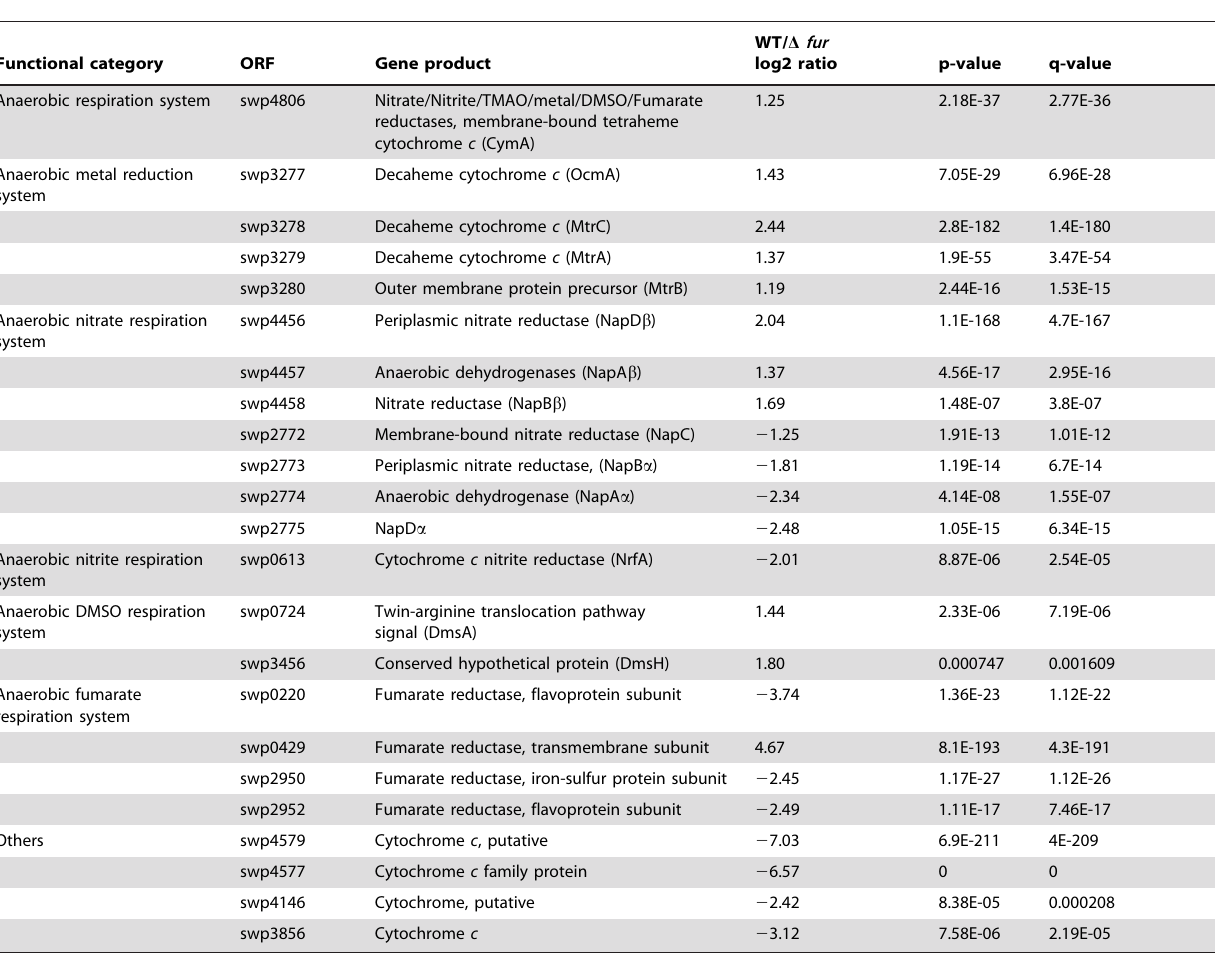
Table 3. Fur-responsive modules for anaerobic electron transport with fumarate as the EA.